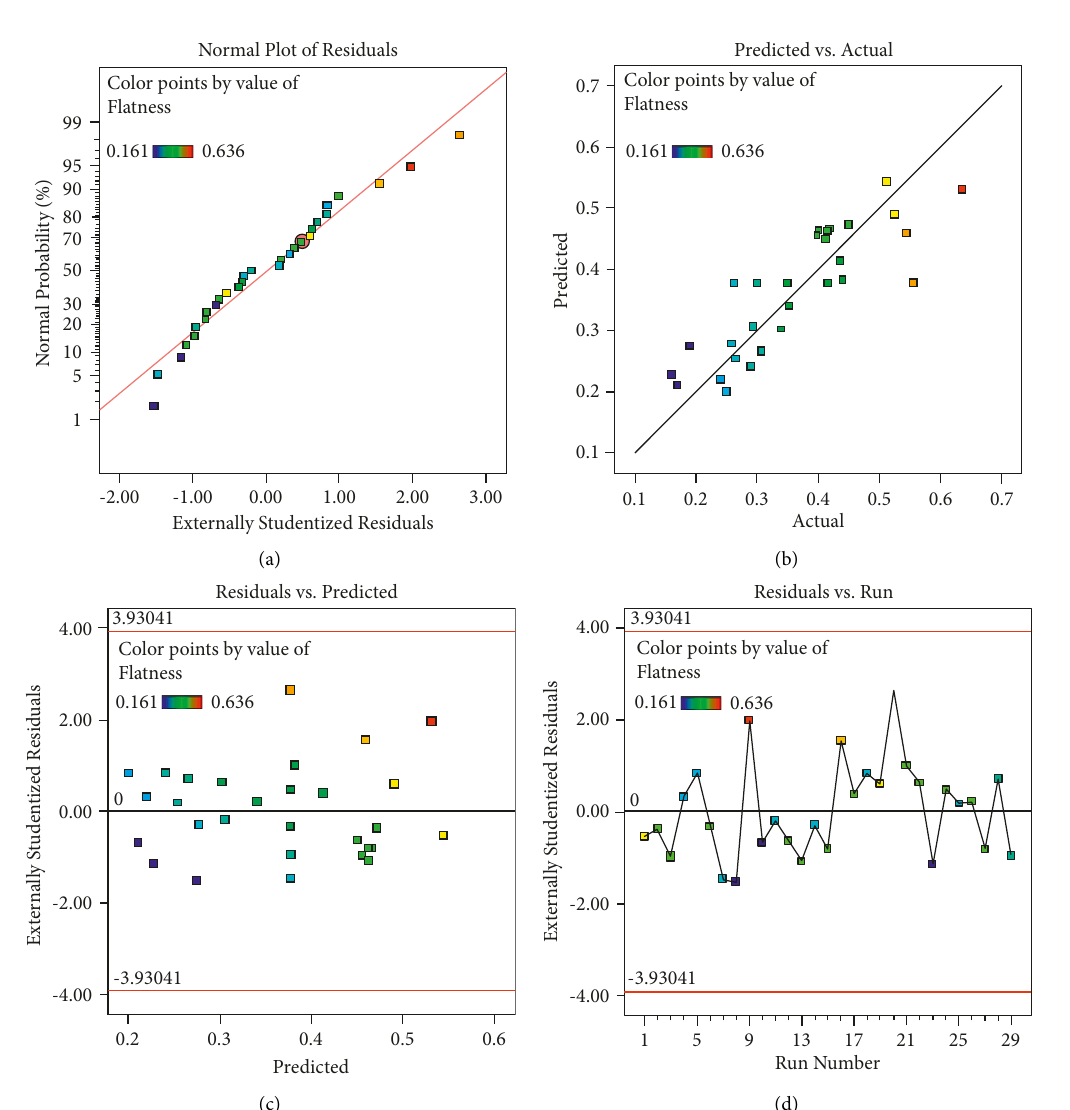
Figure 8: Surface flatness model diagnosis diagrams: (a) the normal distribution of residuals; (b) projected and actual values; (c) predicted values and residuals; (d) serial number and